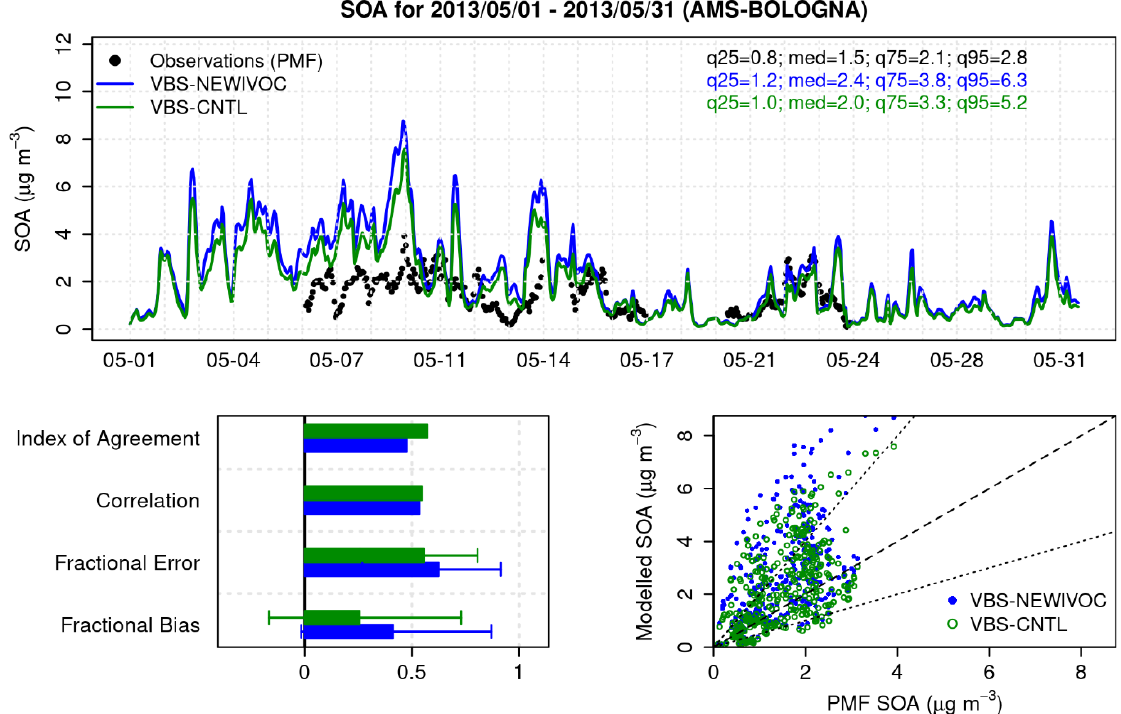
Figure 9. Comparison among modeled and observed (PMF results, black) SOA concentrations in May 2013 at the Bologna site: VBS base scheme (VBS-CNTL, green) and VBS scheme with new parameterizations for IVOC emissions (VBS-NEWIVOC, blue).